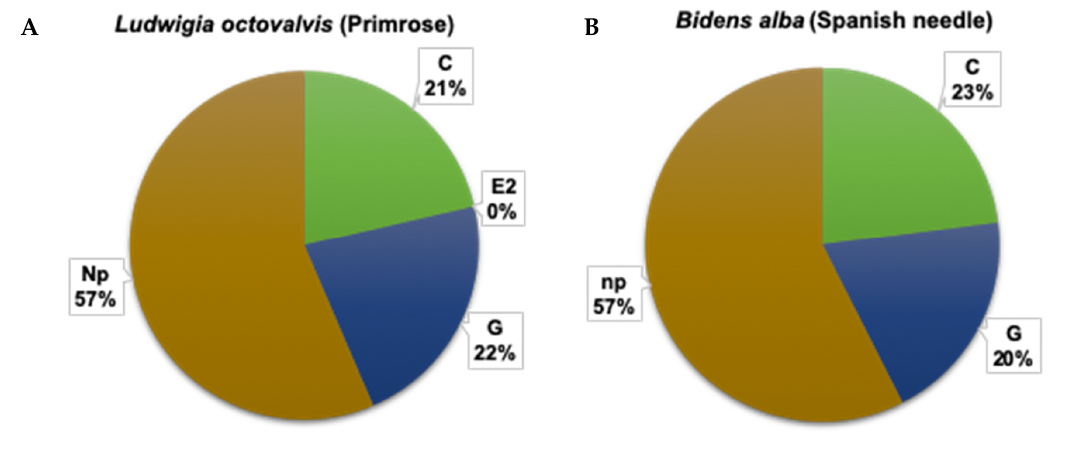
D Figure 3. Cont